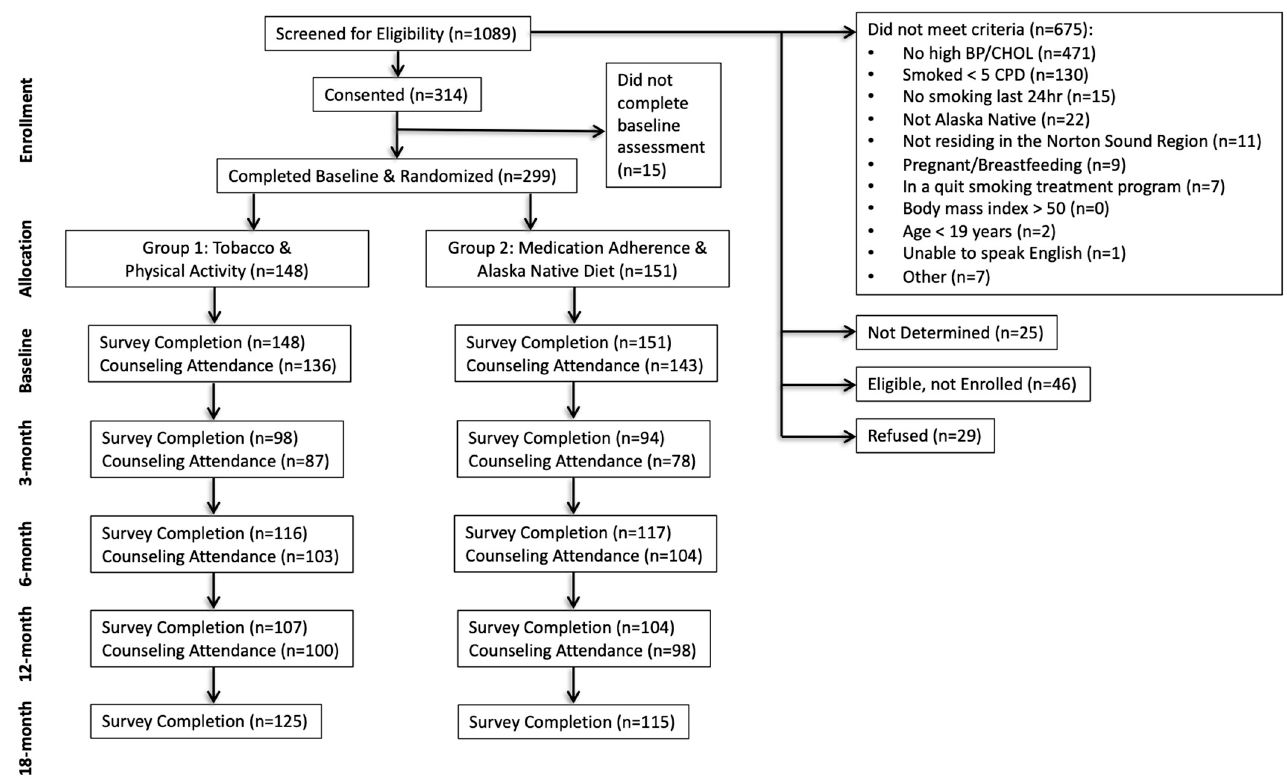
Figure 1. CONSORT diagram. Recruitment and retention by condition at each study check-point.